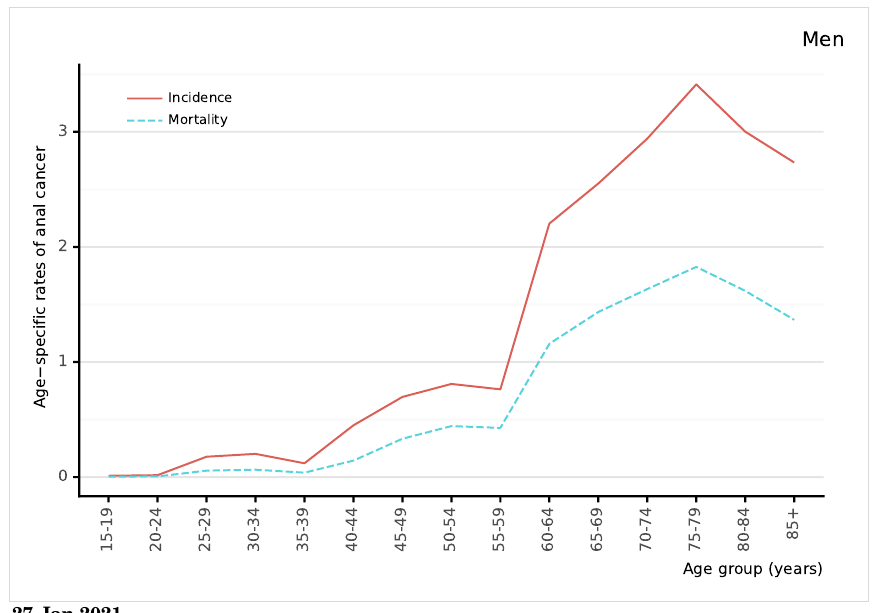
Figure 19: Comparison of age-specific anal cancer incidence and mortality rates among men in India